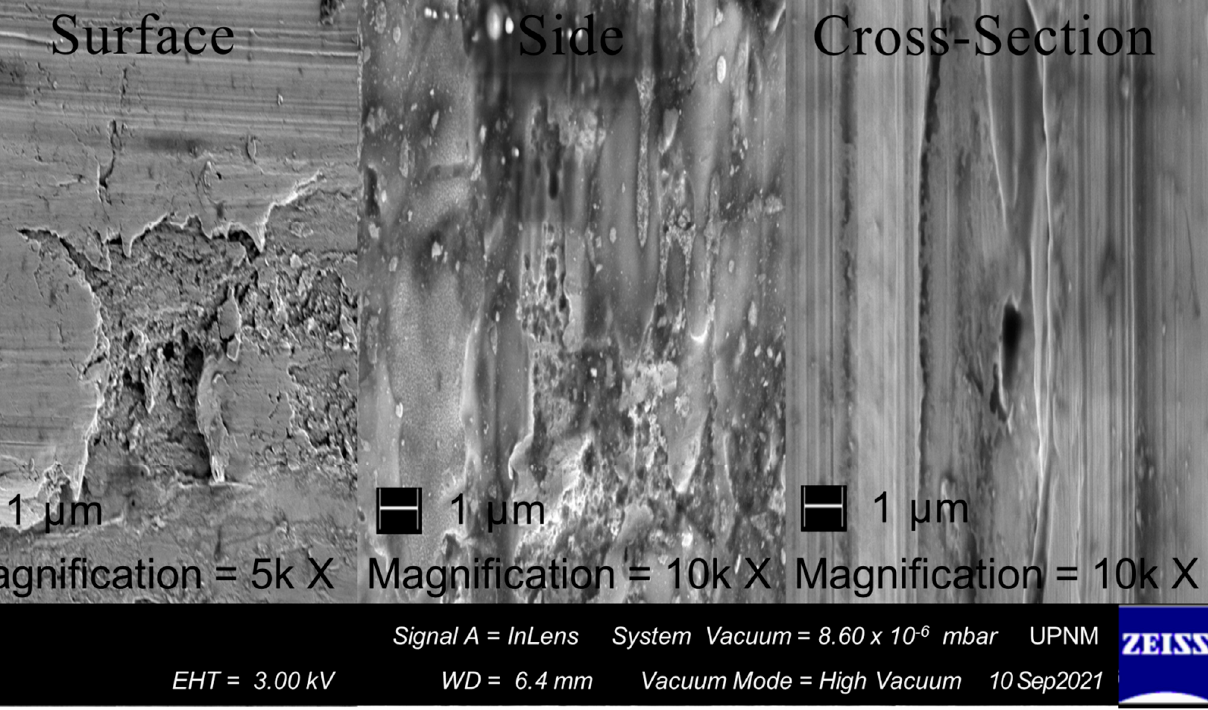
Figure 1. FESEM micrographs of the surface, side and cross ‐ section of the biomaterial.